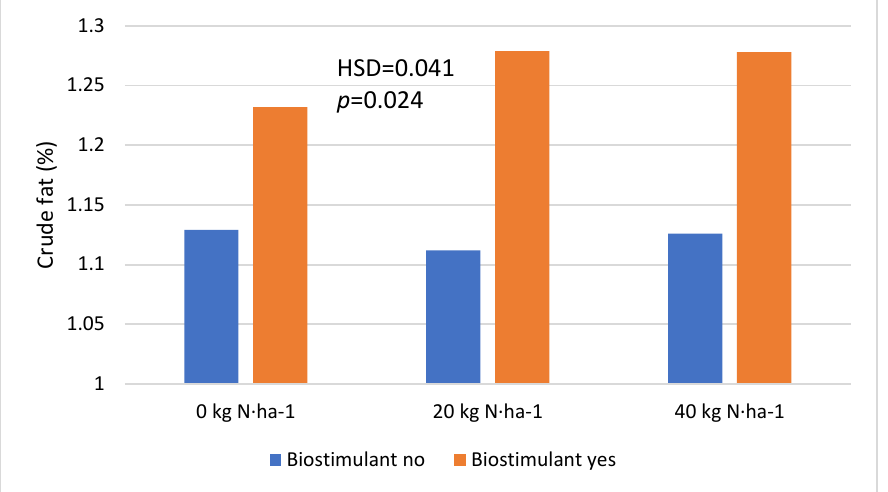
Figure 4. Crude fat content in pea seeds after application of nitrogen fertilization and biostimulant. HSD, honestly significant difference.